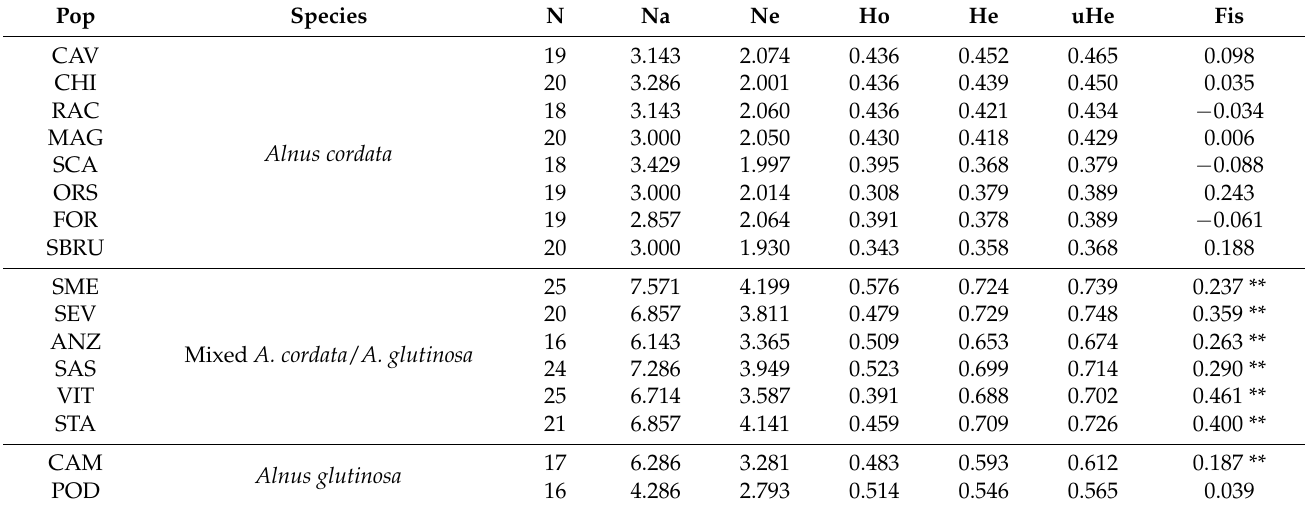
Table 3. Genetic diversity indices of 16 Alnus populations analyzed in this study.